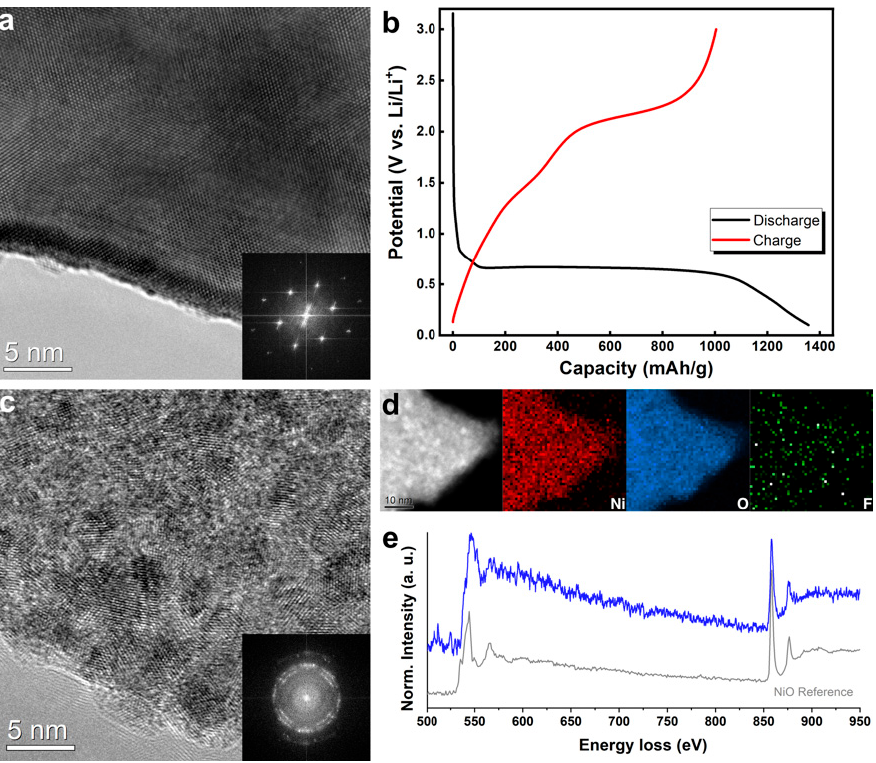
Figure 1. ( a ) A high-resolution TEM (HRTEM) image of pristine NiO. ( b )The discharge–charge voltage profiles for the first cycles acquired from a coin cell. ( c ) An HRTEM image and ( d ) a high-angle annular dark-field scanning TEM (HAADF-STEM) image and the corresponding STEM- electron energy loss spectroscopy (EELS) Ni, O, and F elemental maps obtained from pre-cycled NiO. ( e ) EELS acquired from the NiO after the first cycle with that of the NiO reference. The lithium insertion reaction in the pre-cycled NiO was observed in real time. An open cell was constructed inside of the TEM, as shown in previous reports [9,11,19]. (HAADF-STEM) images during lithiation. A video showing the lithiation reaction is also provided as Video S1 in the Supplementary Materials. As lithium ions were introduced, an expansion of the active material was noticed. The changes in the widths of the pre-cycled NiO in different regions, labeled “A” and “B” (Figure 2a), were tracked for the duration of lithiation (Figure 2b), showing a continuous increase in both A and B. It is noteworthy that volume expansions were noticed in two separate areas simultaneously, indicating that the conversion reaction did not occur successively. Previous works re- ported the initial conversion reactions are a two-phase reaction, where a phase boundary between the reacted and unreacted areas is apparent and the phase boundary moves as lithium ions keep diffusing into the material [10,20–23]. Here, the conversion reaction started in the regions away from each other concurrently (Figure 2a,b), which may result in an S-like discharge profile during the second and following cycles, while the voltage profile shows a plateau during the initial discharge [2,24,25]. The width of the pre-cycled NiO in region A increased by 41.24%, while that in region B increased by 20.11% during observation. Considering that the NiO sample had the morphology of nanosheet [9,23], volume expansion along the z-direction was expected to be negligible. Thus, 99.26% and 44.26% of volume expansion were expected in regions A and B, respectively. Comparing the estimated volume expansion of the NiO with reference [7] suggests that most of the active materials underwent the conversion reaction around region A, while only a por- tion of the materials reacted with the lithium around region B. The degree of conversion reaction may differ depending on the distance from the lithium source. As lithiation proceeded, particulates in the pre-cycled NiO became larger (Figure 2b). According to the Z-contrast of the HAADF-STEM, we can conjecture that the brighter particulates in the